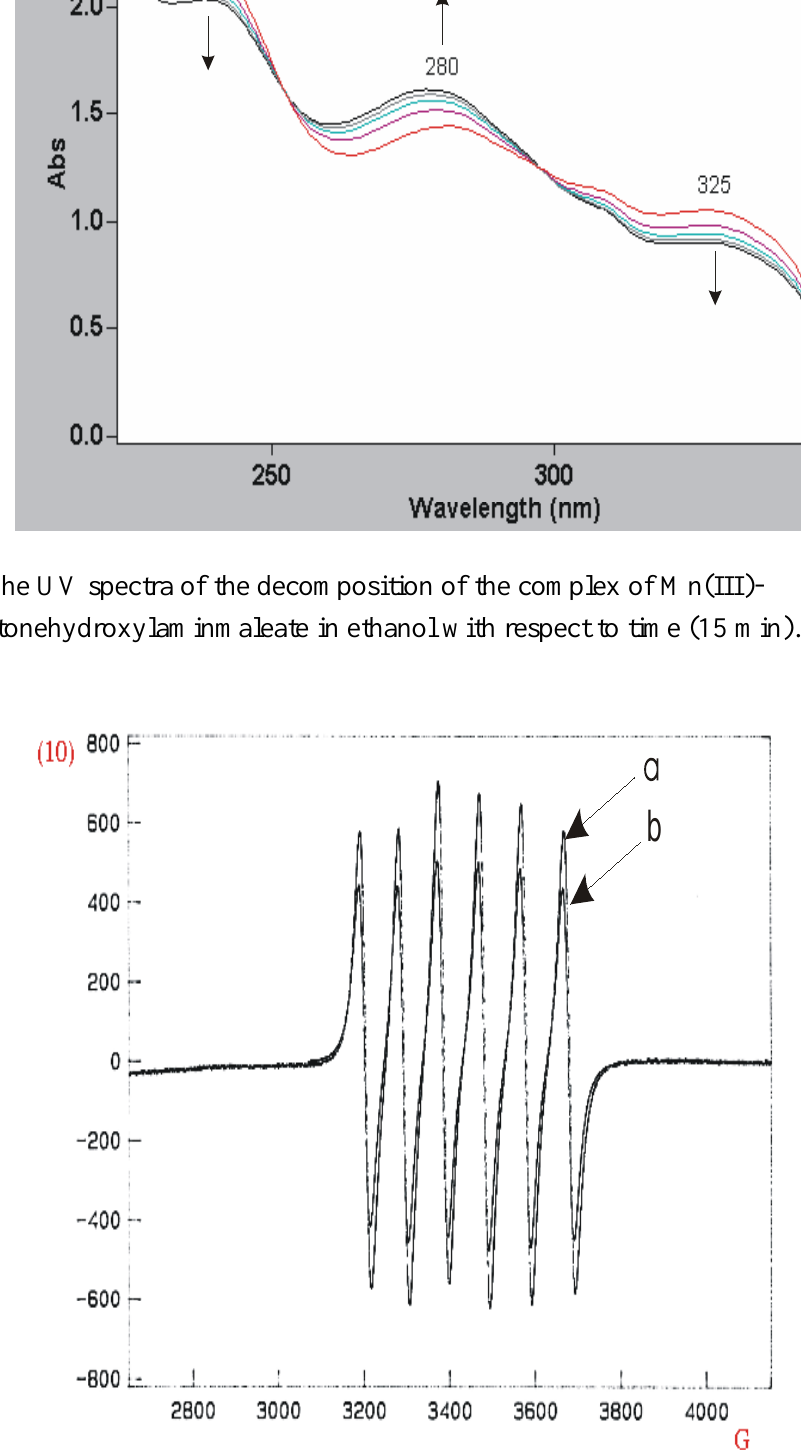
Figure 7. The comparison of the ESR spectra after the balance has been established of Mn 3+ /Mn 2+ a) of Mn(III)-diacetylacetonemaleate, and b) of